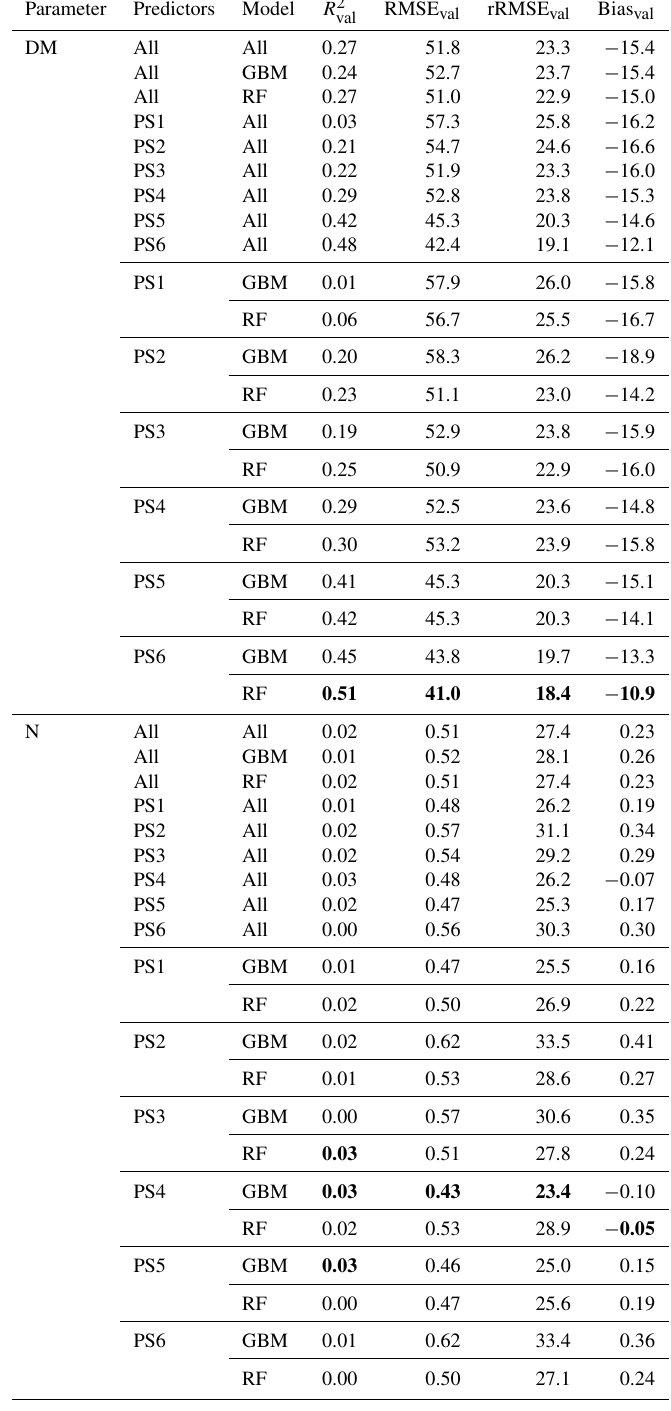
Table 6. External model validation with the EL site using SEQ sensor data. The unit of RMSE val and Bias val of DM is grams per square metre, and it is percent weight for plant N concentration. Shown are all combinations of predictor sets (PS1: raw reflectance data, PS2: VI, PS3: raw reflectance data + VI, PS4: canopy height, PS5: raw reflectance data + canopy height, PS6: raw reflectance data + VI + canopy height), and ML algorithms (GBM, RF). All metric values of single-sensor–predictor set–algorithm combinations are averages of the 10 iterations. Best results in bold. The first nine rows per parameter show aggregated median results (e.g. median of all DM models). N obs =